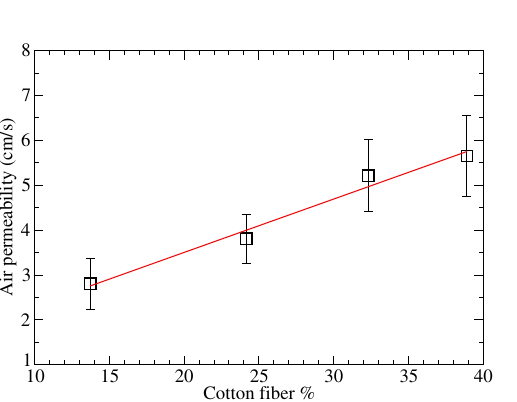
Figure 7. GDL permeability as a function of the cotton fiber content using the Gürley method. Error bars were determined from three different